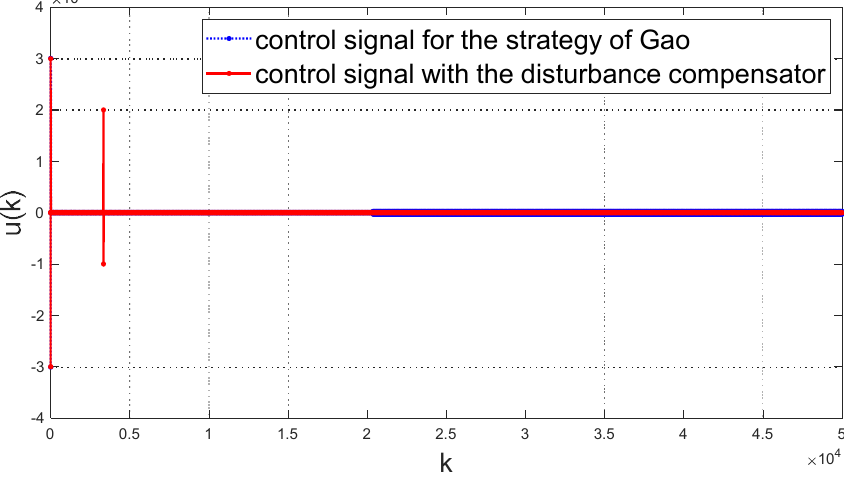
Figure 4. Evolution of the control signal u ( k ).